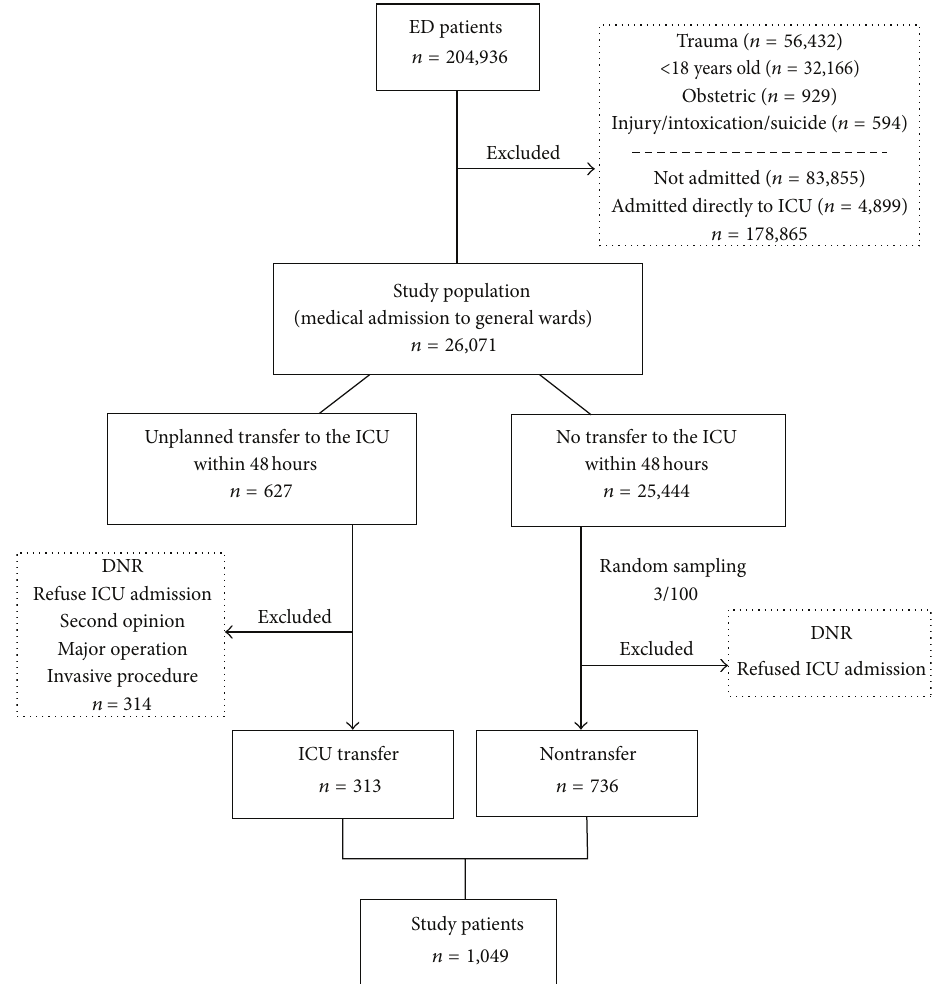
Figure 1: Development of ICU transfer group and nontransfer